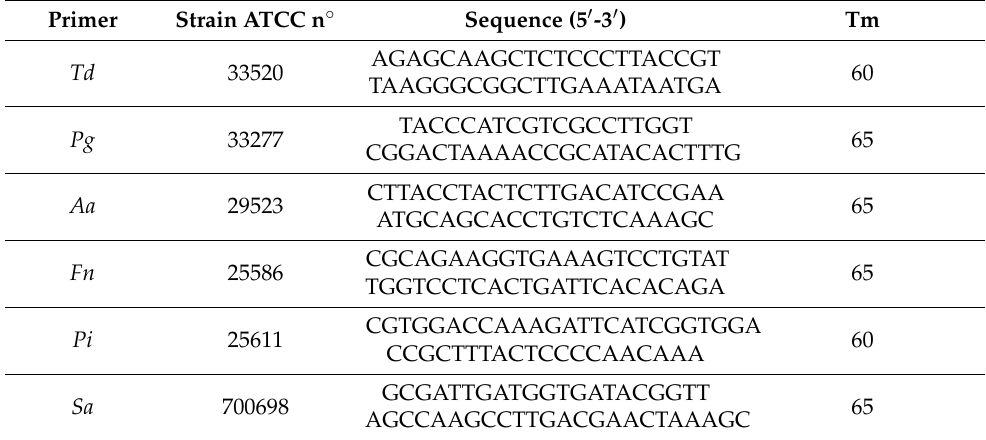
Table 5. Primers’ information for the real-time